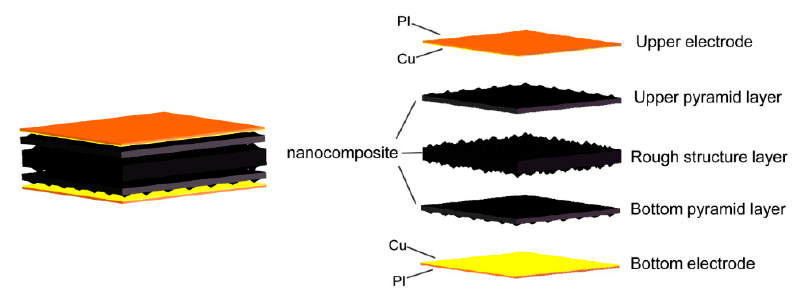
Figure 1. The schematic diagram of the decomposition structure of the tactile sensing device.